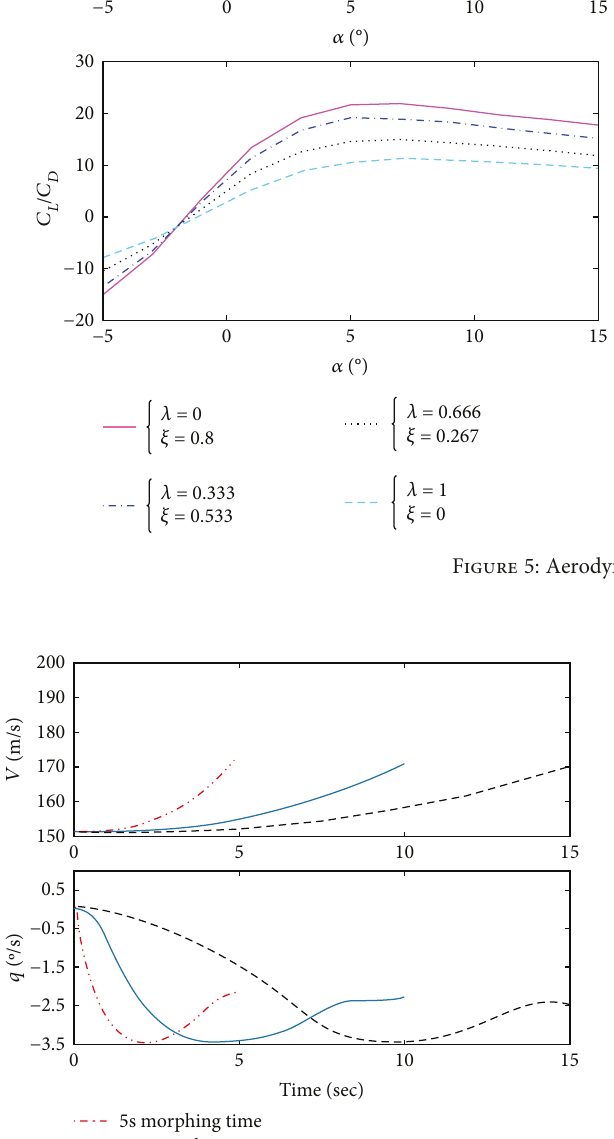
Figure 6: Response variation in di ff erent morphing velocities.